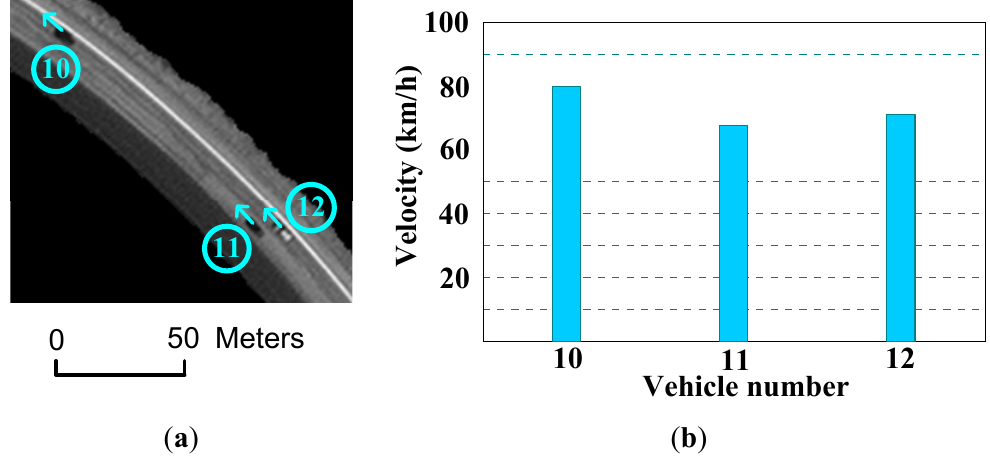
Figure 21. The results of moving vehicles’ speed and direction estimation: ( a ) vehicles on a suburban road labeled with movement directions; ( b ) speed estimation results.